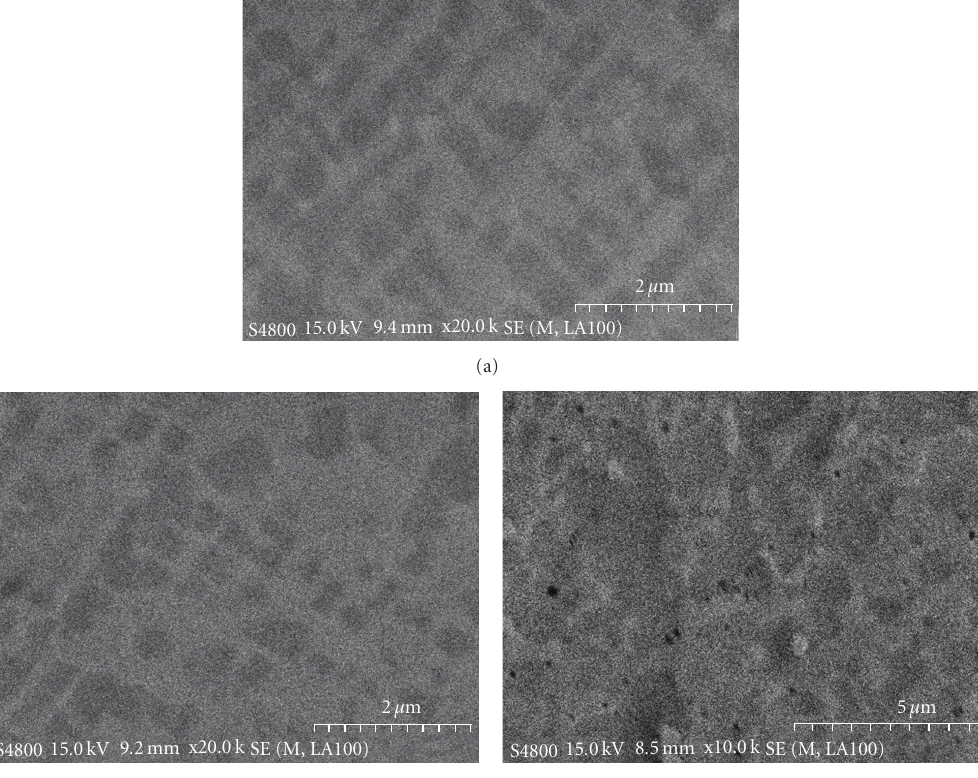
Figure 6: SEM micrographs for MAHP specimens after annealing at 900 ◦ C for 72 h. Ni-15at%Al (a), Ni-15at%Al-0.6at%Y 2 O 3 (b), and MA6000 (c).